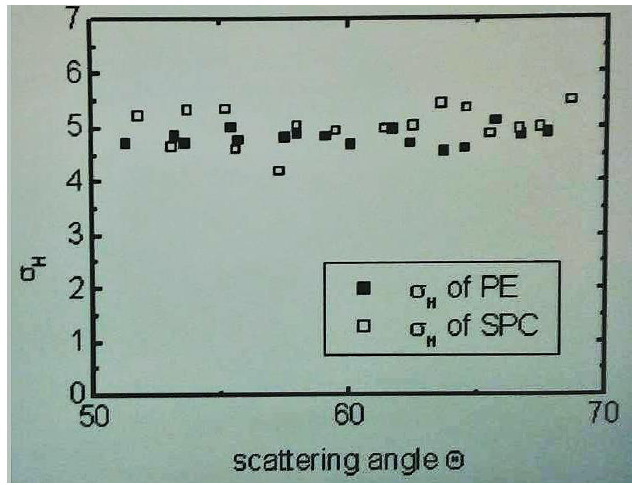
Figure 8. Measured widths σ H (in Å − 1 ) of the Compton profile [16] of H in H 3 OSbTeO 6 (SPC) and of solid polyethylene (PE) at room temperature [30]. The Compton profile is the H momentum distribution along the